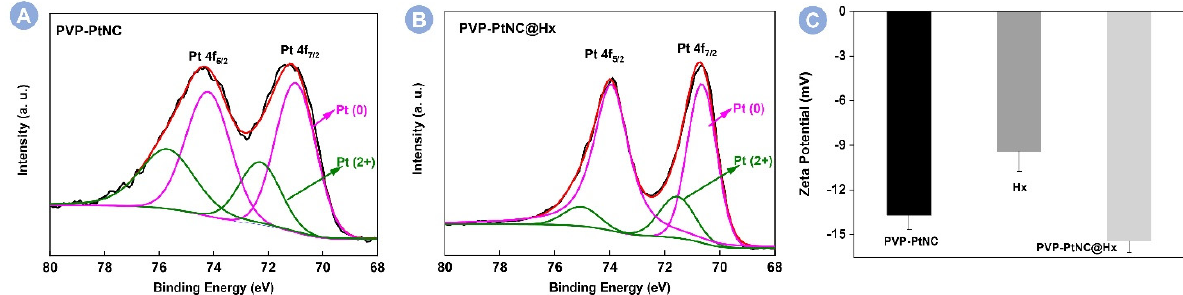
Figure 3. Pt 4f XPS spectra of PVP-PtNC before ( A ) and after ( B ) incubated with Hx. Black, red, magenta, and green lines represent the raw curve, the fitted curve, the Pt (0), and the Pt (II) components’ curves, respectively. ( C ) Zeta potential measurements of PVP-PtNC, Hx, and their mixture.